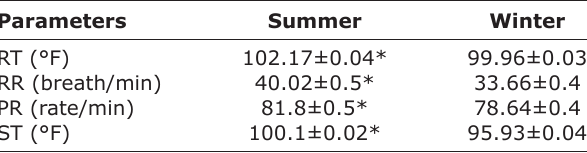
Table-2: Physiological parameters (mean±SE) during summer and winter season.